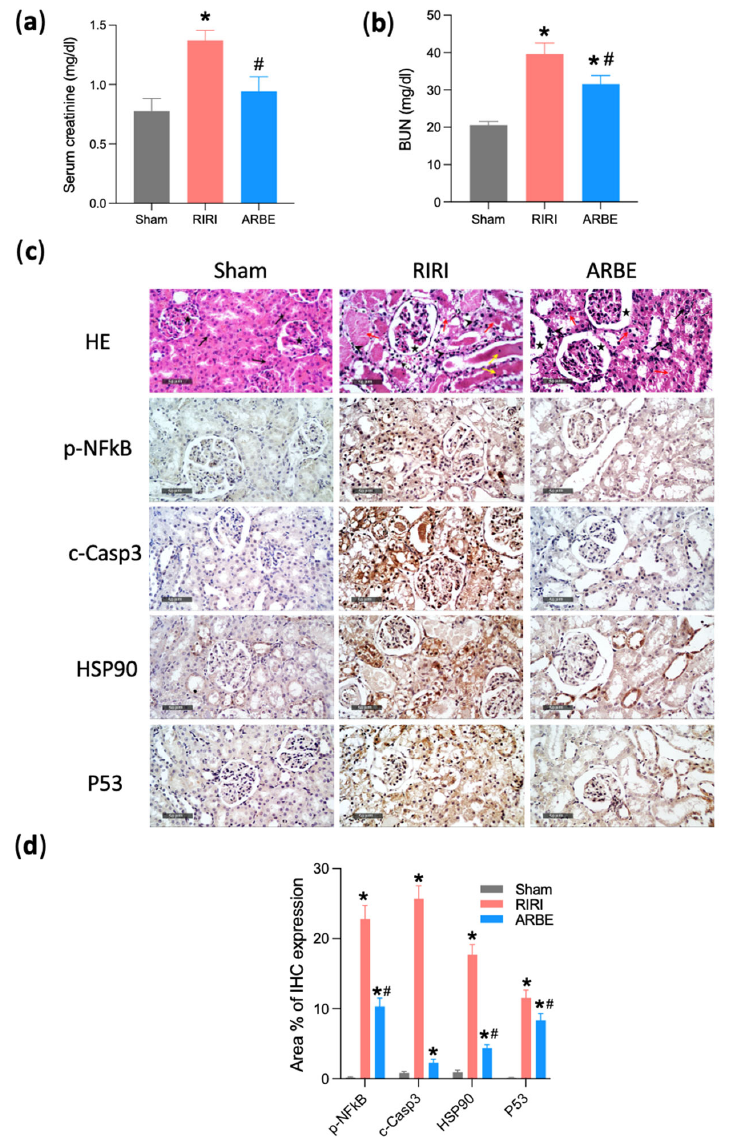
Figure 11. In vivo validation of the protective effect of ARBE against RIRI. ( a ) Serum creatinine. ( b ) Blood urea nitrogen (BUN). ( c ) Microscopic examination and immunohistochemical studies (Scale bar, 50 µ m). ( d ) Quantification of immunohistochemical (IHC) expression. * p < 0.05 vs. sham, # p < 0.05 vs.